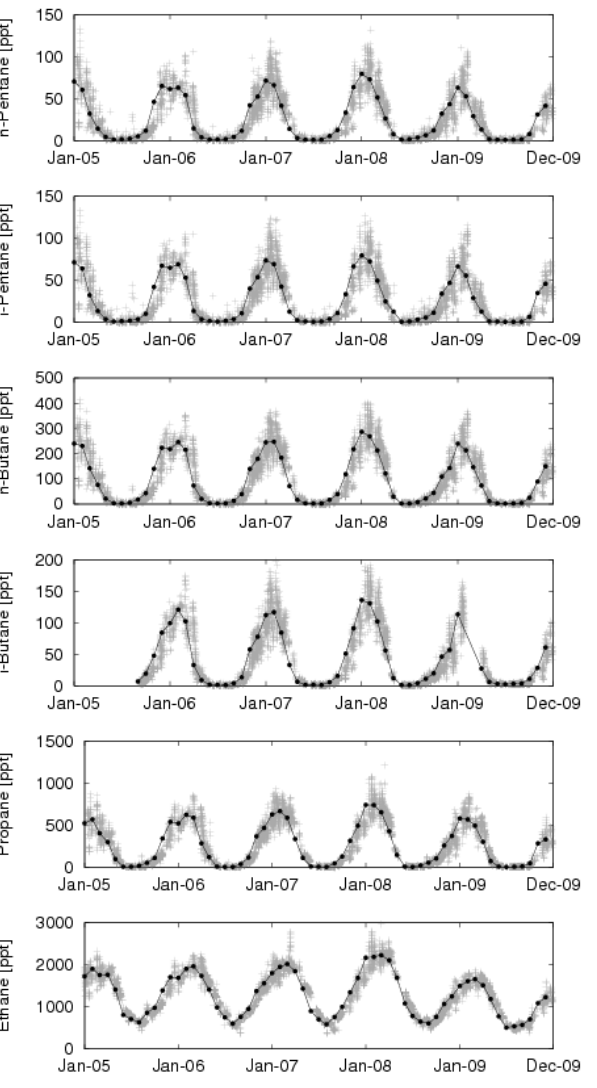
Figure 3: Baseline data for C 2 -C 5 alkanes from January 2005 until December 2009 with 2 Fig. 3. Baseline data for C 2 –C 5 alkanes from January 2005 until December 2009 with monthly averaged data overlaid in black. monthly averaged data overlaid in grey. 3